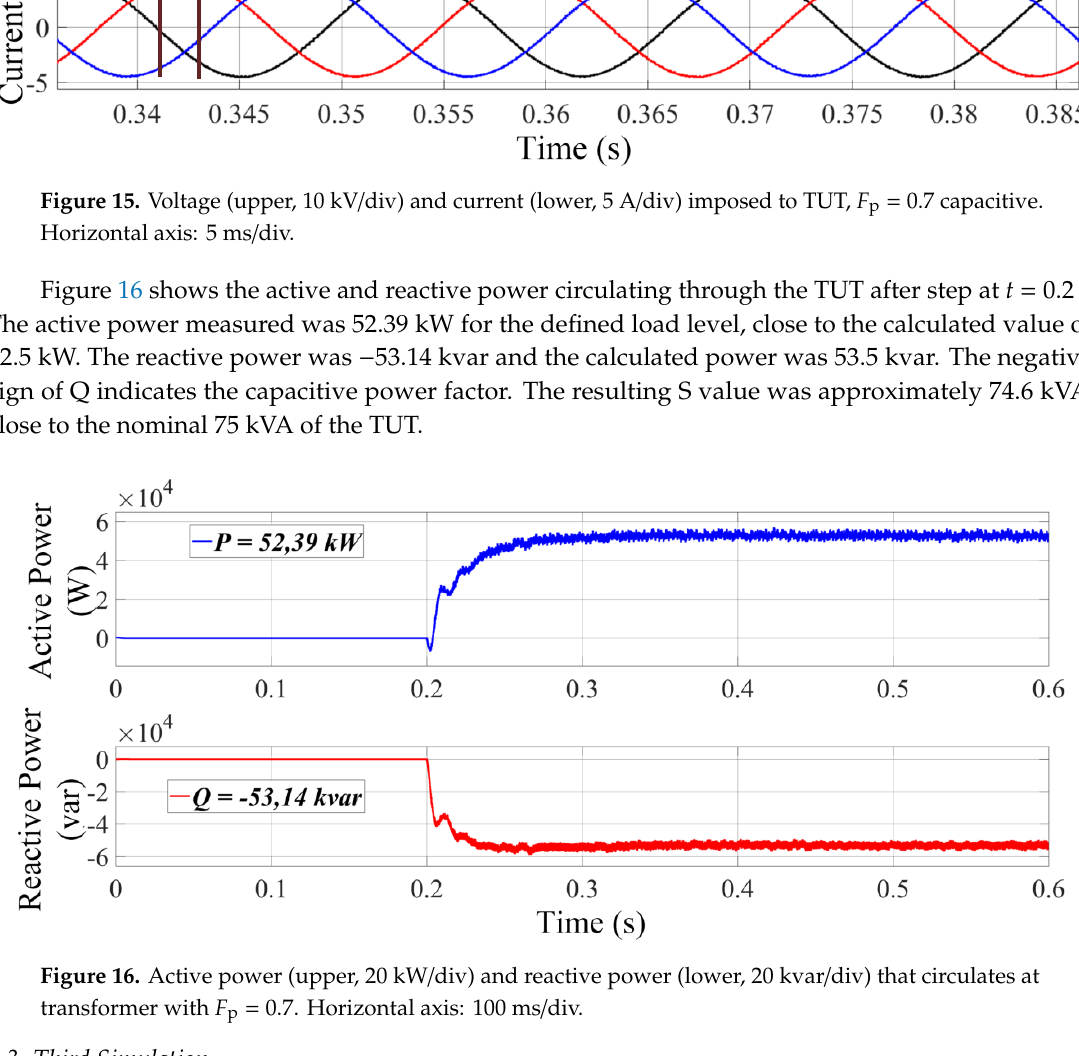
Figure 14. Direct axis current (blue) and quadrature axis current (red) measured at HV of system to F p = 0.7. Vertical axis: 1 A/div. Horizontal axis: 100 ms/div.